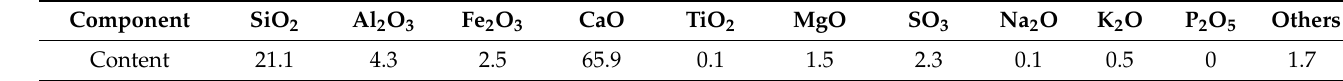
Table 3. Chemical composition of cement.